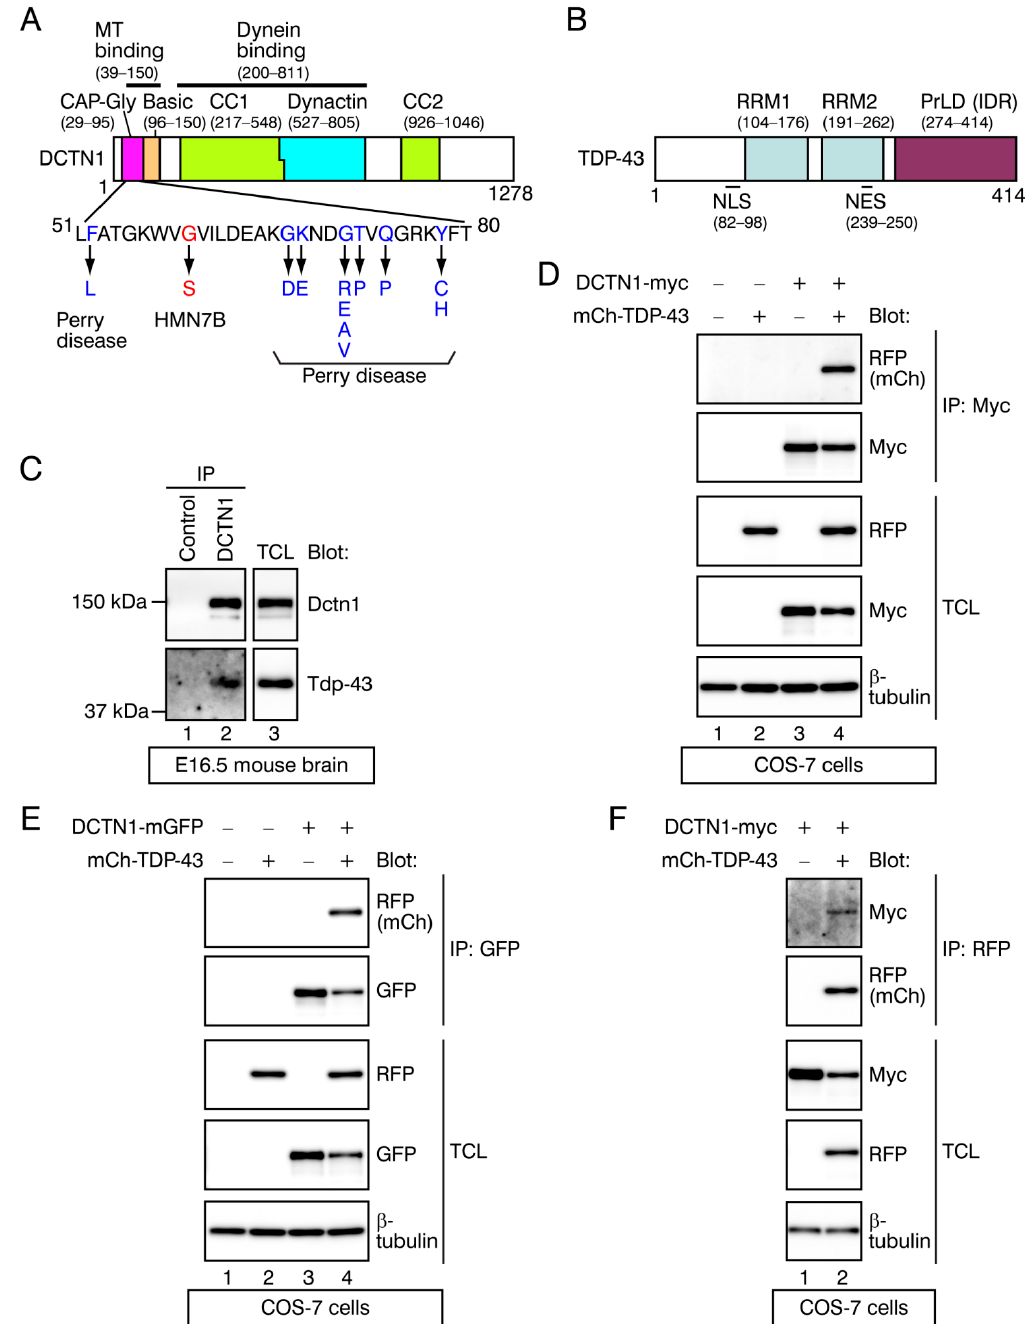
Figure 1. Interactions between DCTN1 and TDP-43. ( A , B ) Schematic diagrams of DCTN1 ( A ) and TDP-43. ( B ). In ( A ), disease-linked mutations within the DCTN1 CAP-Gly domain are indicated. In ( B ), the domain architecture of TDP-43 was modified from Winton et al. [20] and Guo et al. [21]. MT: microtubule. ( C ) Detection of interactions of endogenous Dctn1 and Tdp-43 proteins in E16.5 mouse brains. Whole brain lysates were immunoprecipitated with a control IgG or an anti-DCTN1 antibody. The immunoprecipitates and lysates were probed with antibodies as indicated in Western blots. IP: antibody used for immunoprecipitation; Blot: antibodies used for Western blotting. TCL: total cell lysates. ( D , E ) Interactions between DCTN1-myc ( D ) or DCTN1-mGFP ( E ) and mCherry-TDP-43 (mCh-TDP-43) proteins expressed in COS-7 cells were detected by coimmunoprecipitation. Tagged DCTN1 was immunoprecipitated using anti-myc or anti-GFP, and mCherry-TDP-43 in the immunoprecipitates was detected using anti-RFP. ( F ) Coimmunoprecipitation of DCTN1-myc and mCherry-TDP-43 in COS-7 cells in the reverse direction, relative to ( D ); mCherry-TDP-43 was immunoprecipitated using anti-RFP, and DCTN1-myc in the immunoprecipitates was detected using